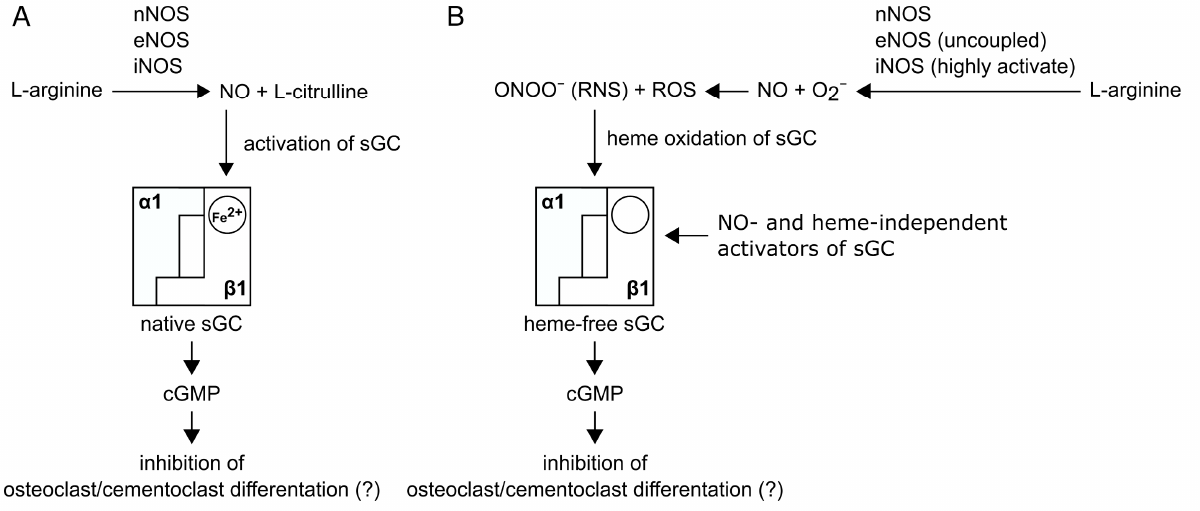
Figure 8. Schematic illustration of the possible role of sGC in the NO-cGMP signaling cascade in osteoclasts and cementoclasts of the human periodontium (modified from [44]): ( A ) In osteoclasts and cementoclasts of healthy periodontium, nitric oxide (NO) is synthesized from the amino acid L-arginine by activated neuronal (n), endothelial (e), and/or inducible (i) NO synthase (NOS). At physiological concentrations, NO binds to the heme of the β 1-subunit of soluble guanylyl cyclase (sGC), thereby activating the heterodimeric α 1 β 1-isoform, which leads to increased production of cGMP from GTP. This could result in inhibition of osteoclast and cementoclast differentiation. ( B ) In osteoclasts and cementoclasts of the inflamed periodontium, the β 1-subunit of sGC is oxidized (Fe 3+ ) by the formation of reactive oxygen species (ROS) and reactive nitrogen species (RNS) and therefore exists in a NO-insensitive state. Nevertheless, as in healthy periodontium, sGC is also present in osteoclasts and cementoclasts in inflamed periodontium at the protein level. Inactivation of sGC may lead to increased osteoclast and cementoclast differentiation in periodontitis. Pharmacological activation of the α 1 β 1-isoform of sGC in cementoclasts and osteoclasts by NO- and heme-independent activators of sGC could therefore be considered a novel treatment strategy to inhibit both cementum and alveolar bone resorption [12,45].